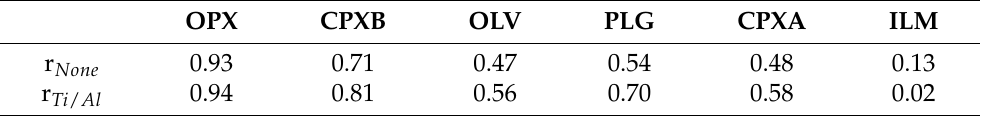
Table 3. Pearson r coefficients for the relationship between theoretical smFe abundance and standard deviation of the respective endmembers. Except for ilmenite with an elemental prior all correlation coefficients are positive. Therefore, with increasing smFe abundance, the uncertainties of the mineral abundances